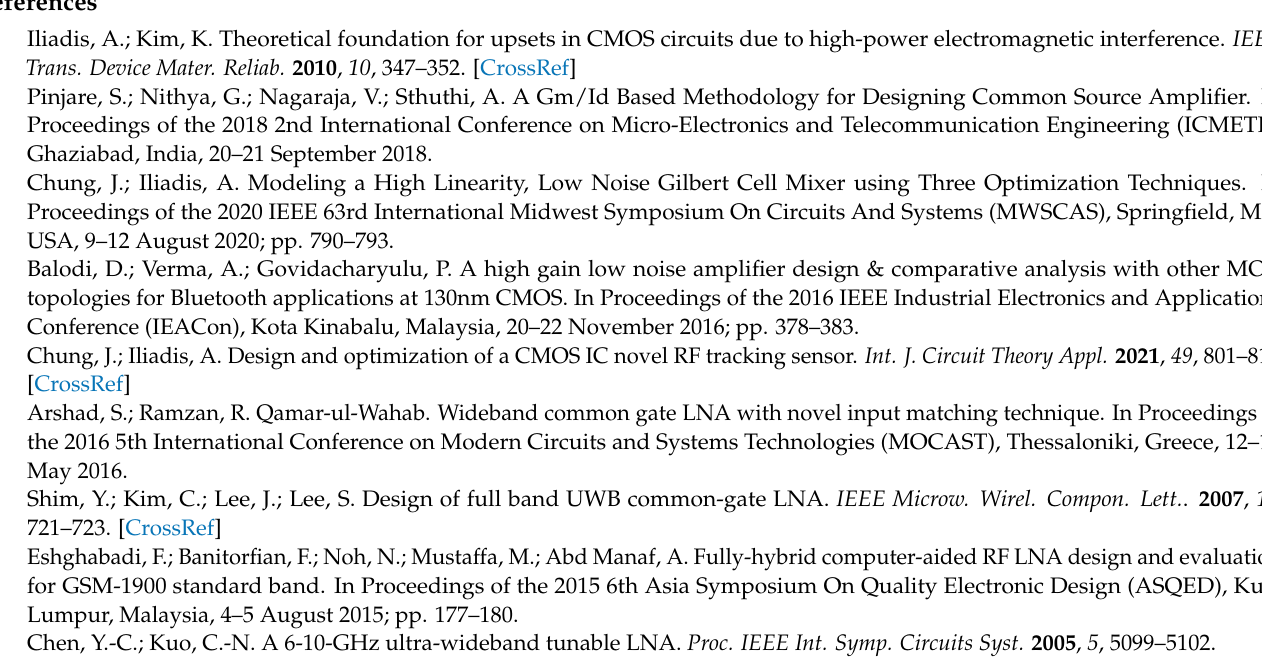
algorithm and the FoM index method. The device is based on 180 nm CMOS technology and operates at f 0 = 2.4 GHz. Design parameters were determined using g m / I D vs. V ov , f t vs. V ov , and I D / W vs. V ov data charts (Figures 2 and 3) and computing the FoM to demonstrate an optimal bias point. The results revealed that optimal values for S 21 and noise figure were obtained at V ov = 0.1 V (Table 1) where great linearity is obtained without any significant degredation in the S 21 parameter and noise. A comparison of this LNA and previous works in Table 2 shows high linearity and power efficiency with comparble S 21 and NF. The figure of merit was computed to guide the parametric optimization. The optimized model showed S 21 = 19.91 dB, NF = 3.54 dB, IIP 3 = 5.89 dBm, P DC = 9 mW, and the FoM index method